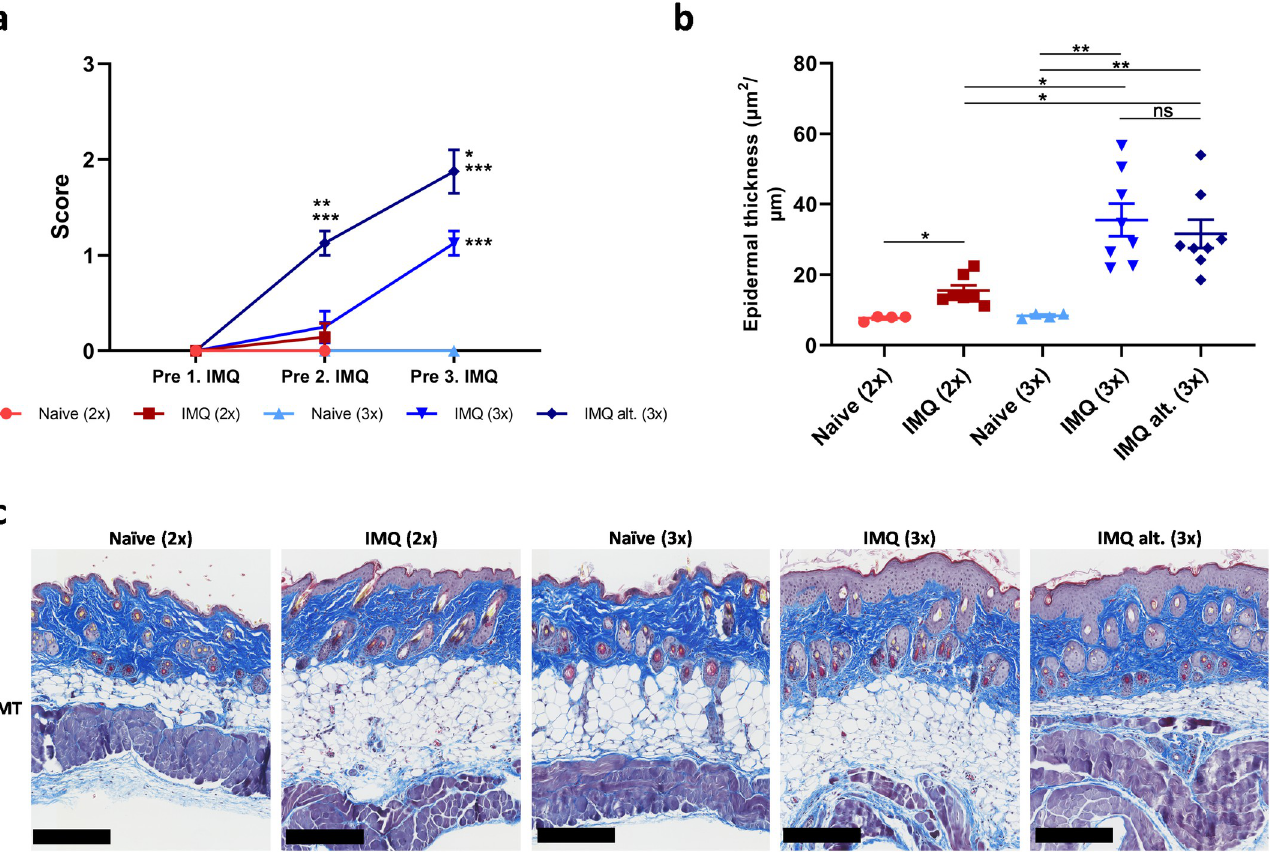
Fig 3. IMQ induced a clinical skin inflammation and increased epidermal thickness. (a) Cumulative clinical score of the skin before the first, second and third IMQ application (Denoted pre 1., 2. and 3. IMQ in the figure). (b) Epidermal thickness measured with Visiopharm software from Masson’s Trichrome (MT) stained skin at sacrifice. (c) Masson’s Trichrome (MT) stained skin. Representative slides are shown. The bar equals 250 μ m.